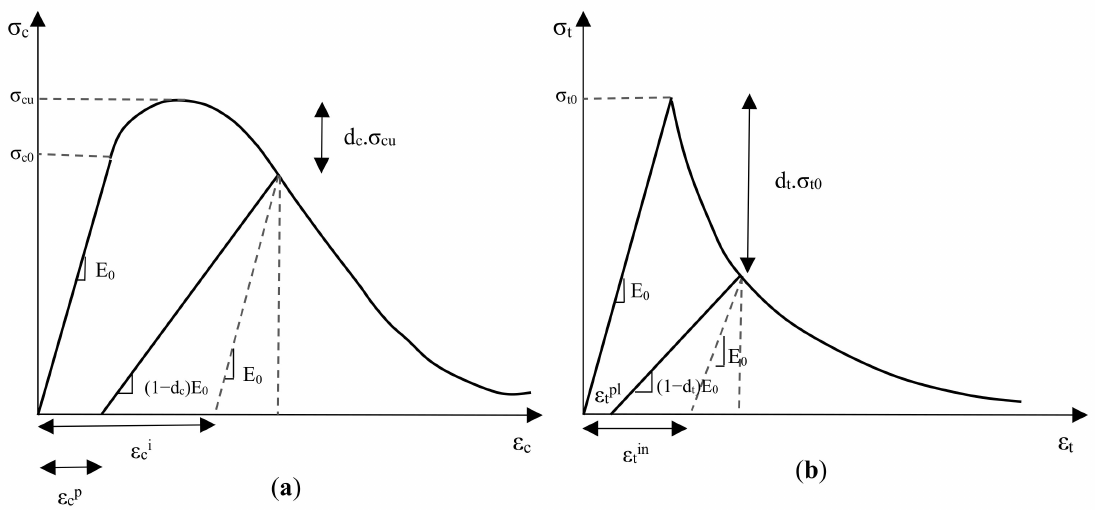
Figure 8. Stress-strain relationship for CDP model ( a ) in compression ( b ) in